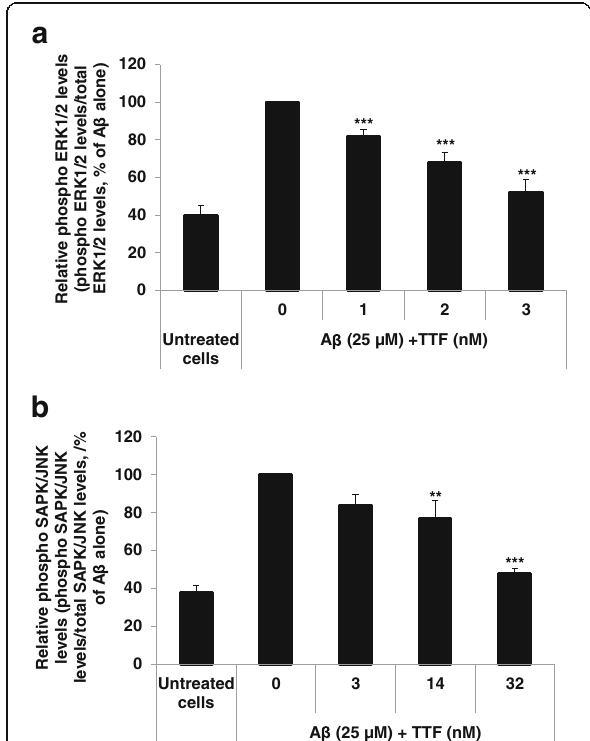
Fig. 4 TTF suppresses A β -induced phosphorylation of SAPK/JNK, and ERK 1/2 in N2a cells. Cells were treated concomitantly with 25 μ M of A β and TTF for 30 min (ERK 1/2) or 40 min (SAPK/JNK). Cells were extracted and the levels of phosphorylated and total ERK 1/2 ( a ) and SAPK/JNK ( b ) were determined with specific ELISA kits. The levels of each of the phosphorylated proteins were normalized to the levels of the total amount of the related proteins, and are presented as means ± SEM of two experiments ( n = 4) for SAPK/JNK, and of three experiments ( n = 6) for ERK 1/2. **p < 0.01, ***p < 0.001, for comparison with cells that were treated with A β